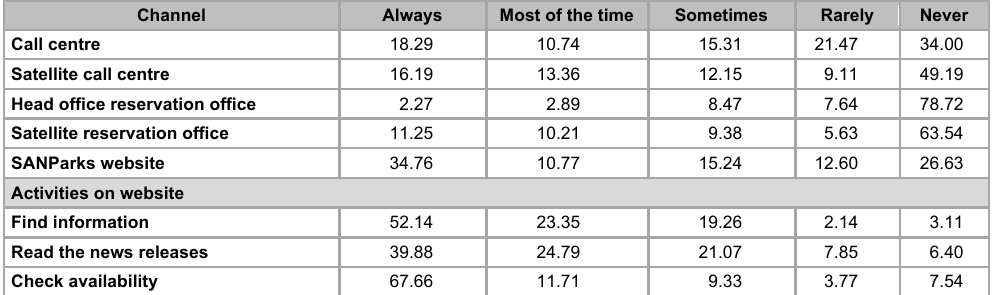
Frequency percentage with which SANParks distribution channels are being used and activities conducted on the SANParks